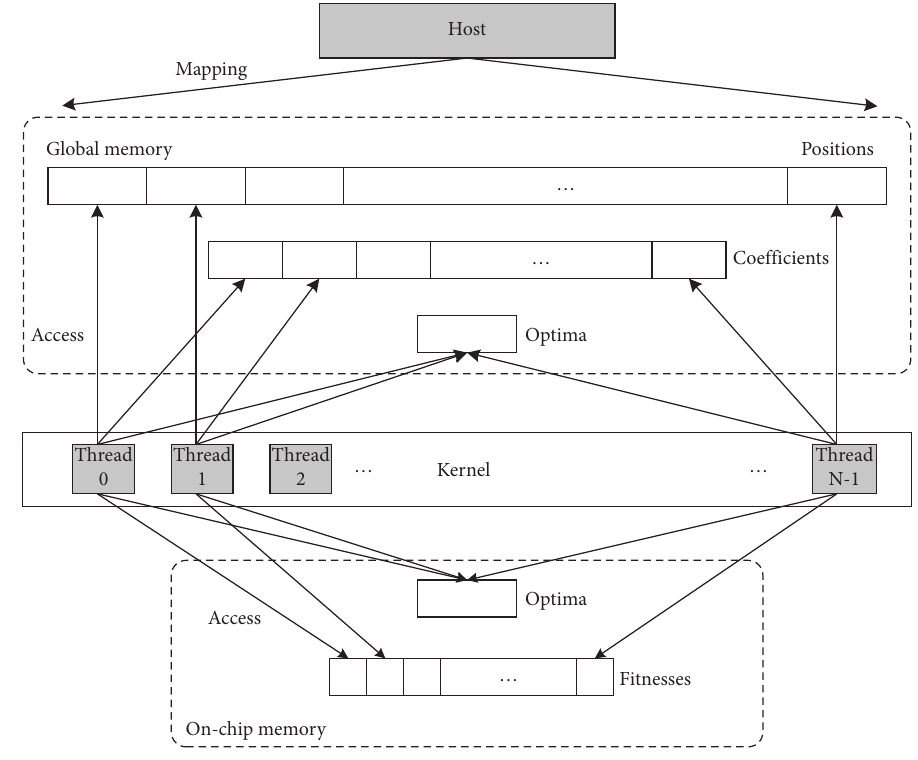
Figure 6: Dataflow of PWOA-AFPM between host and